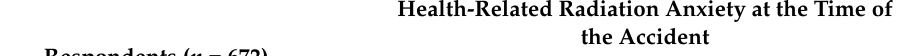
Table 3. Categorization of continuing, emerging, improved, and no strong health-related radia- tion anxiety.